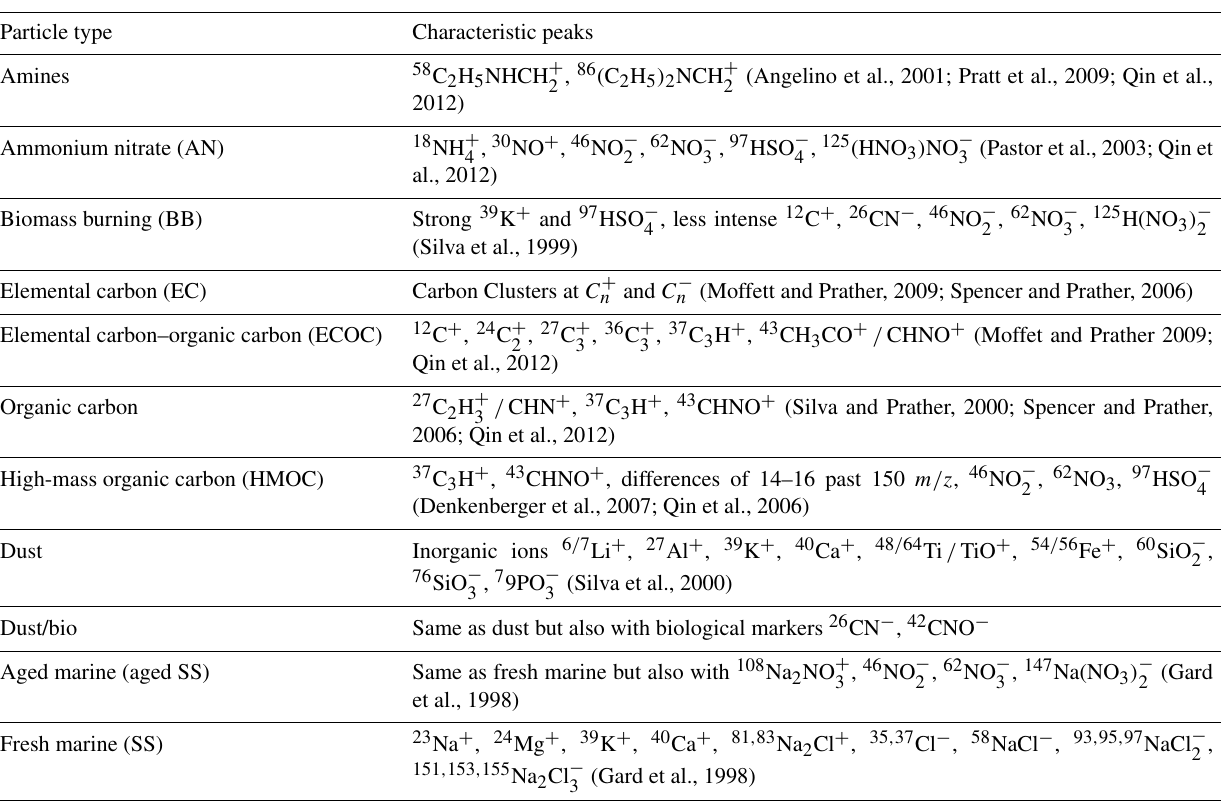
Table 2. Summary of particle types determined by ATOFMS and their characteristic ion